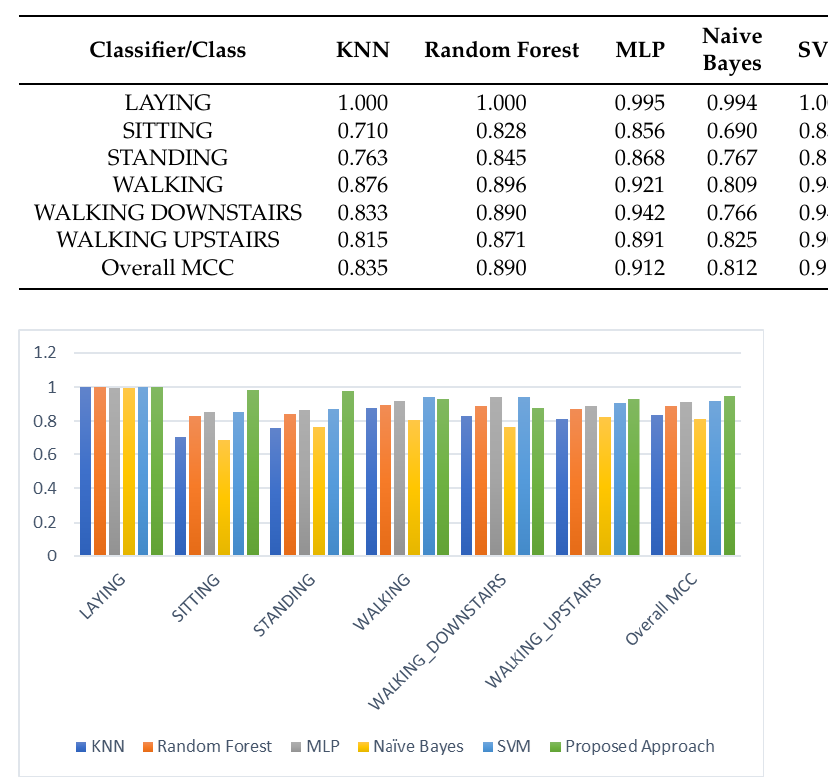
Figure 9. Detailed F-measure by Class. Table 6. Detailed MCC by Class.